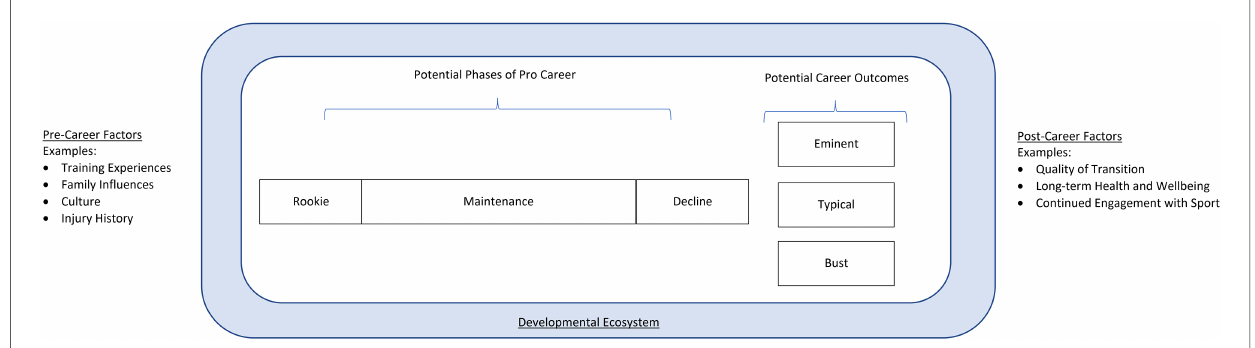
FIGURE 1 A proposed model of stages of a professional career. Each stage (i.e., initiation, maintenance, decline) will have speci fi c goals and objectives that link to different performance and development outcomes. Furthermore, stages will be in fl uenced by pre-career factors and the developmental ecosystem surrounding the athlete (e.g., organizational priorities, quality and nature of support system and resources, training and education available for those in developmental roles). Effective management of these objectives will in fl uence post-career